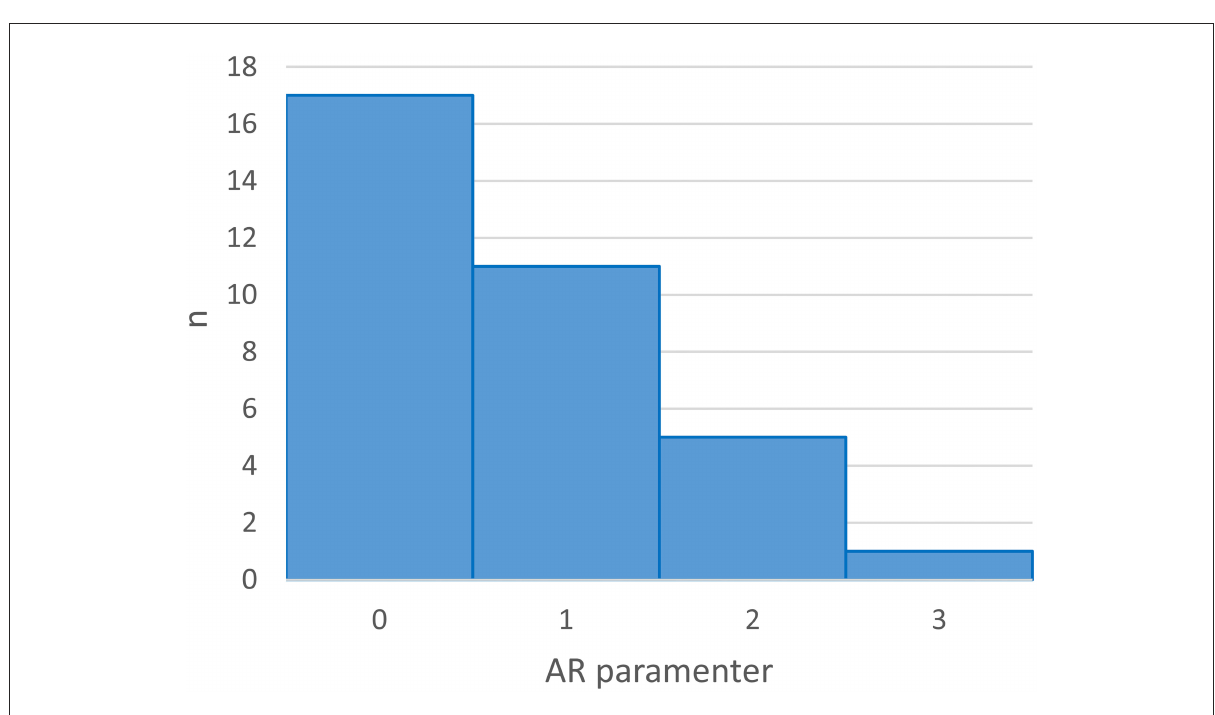
FIGURE5 Histogram of AR term values in individual participant’s ARIMA